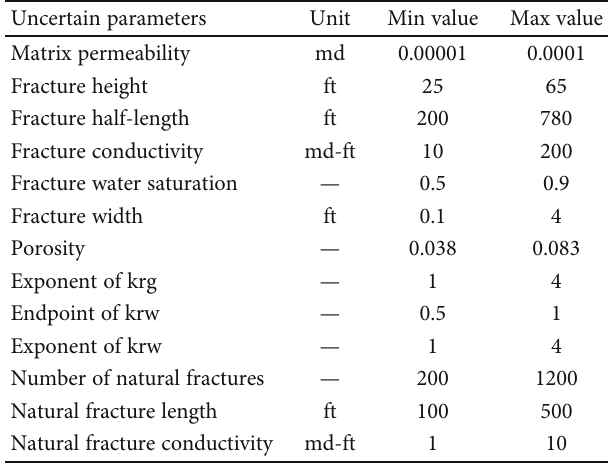
Table 2: Summary of ranges of 13 uncertain parameters used in this study [26].